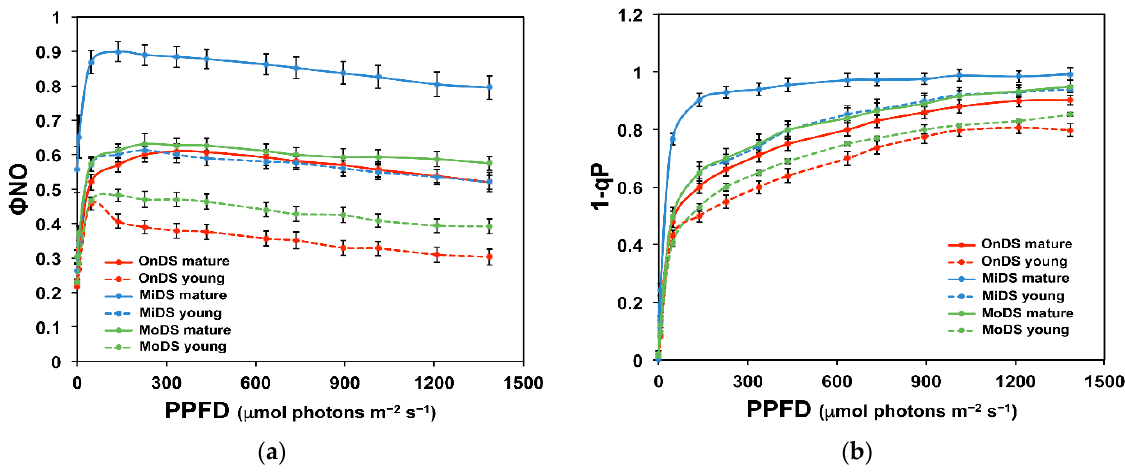
Figure 4. Light response curves of non-regulated energy dissipated in PSII ( Φ NO ) ( a ) and of excitation pressure (1 − q p ) ( b ), in A. thaliana young and mature leaves at the onset of drought stress (OnDS), at mild drought stress (MiDS) and at moderate drought stress (MoDS). Error bars represent ± standard error of the mean (n = 5–6).